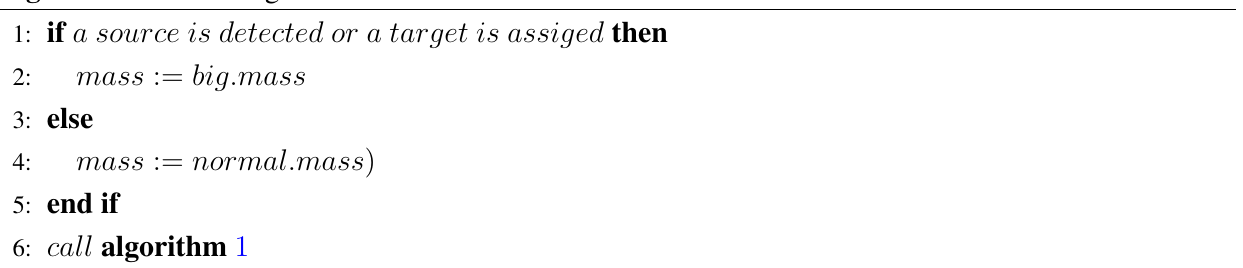
Algorithm 2 Switching